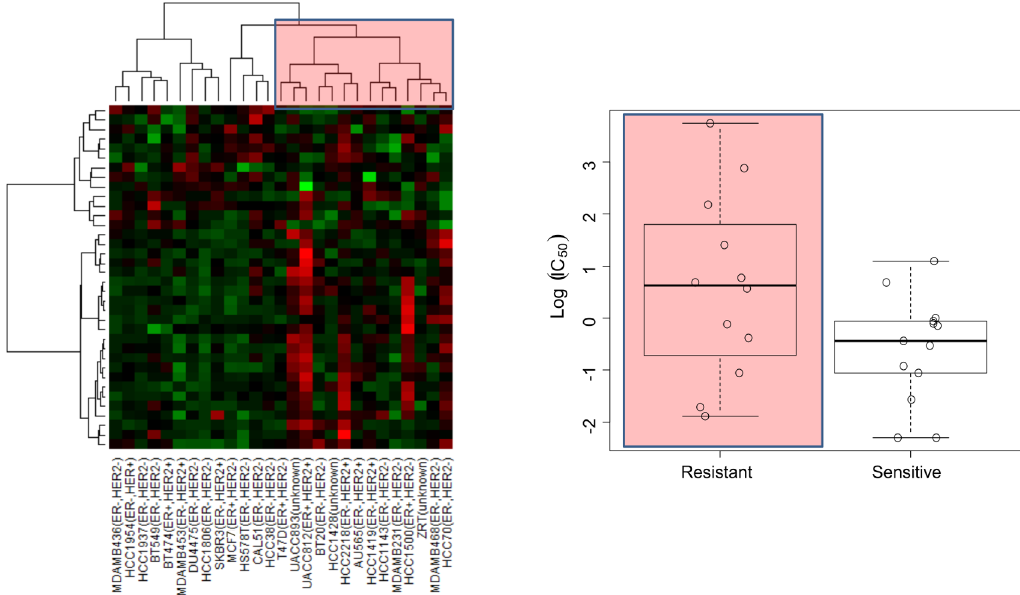
Figure 3. The EMT expression profile correlates with eribulin sensitivity. Unsupervised hierarchical clustering defined groups of breast cancer cell lines with altered expression under eribulin treatment (left panel). The cell lines consisting of many upregulated EMT genes are more resistant to eribulin treatment (right panel, p=0.06). The ER and HER2 status of cell lines are indicated in the parenthesis. doi:10.1371/journal.pone.0106131.g003 PLOS ONE |